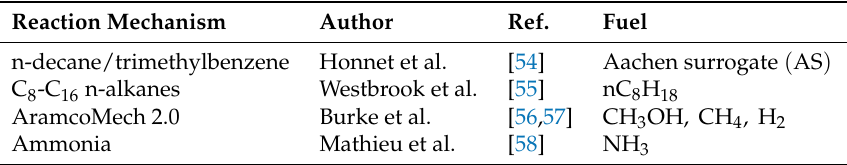
Table 2. Detailed kinetic reaction mechanisms used in this